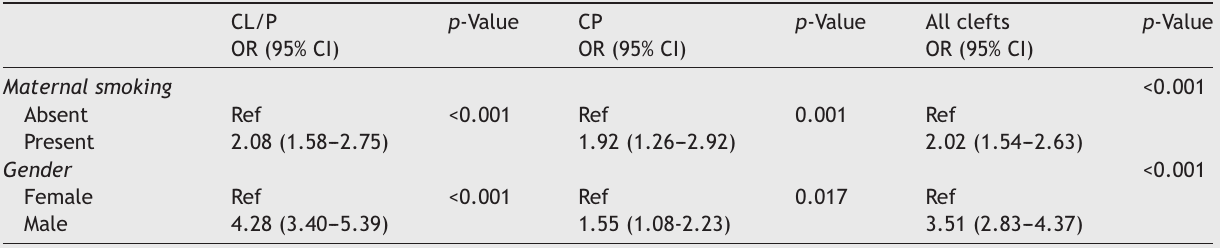
Table 1 Univariate analysis of the distribution of cleft lip with or without cleft palate (CL/P), cleft palate (CP), and all clefts according to maternal smoking status and infant